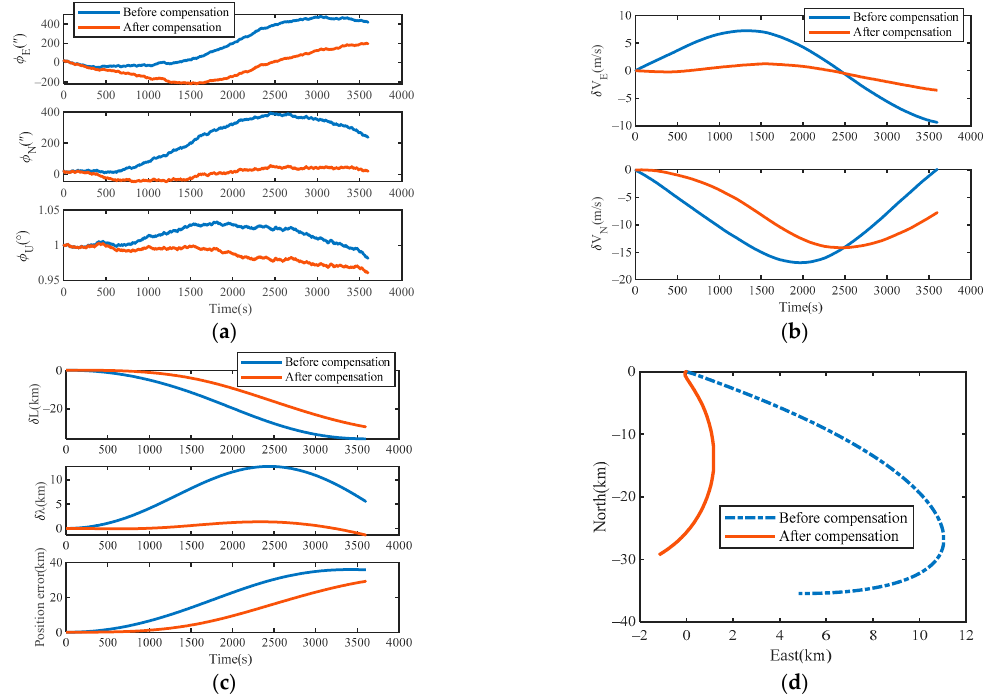
Figure 9. ( a ) Simulation results of attitude errors; ( b ) simulation results of velocity errors; ( c ) simulation results of position errors; ( d ) compare the trajectory of the carrier.